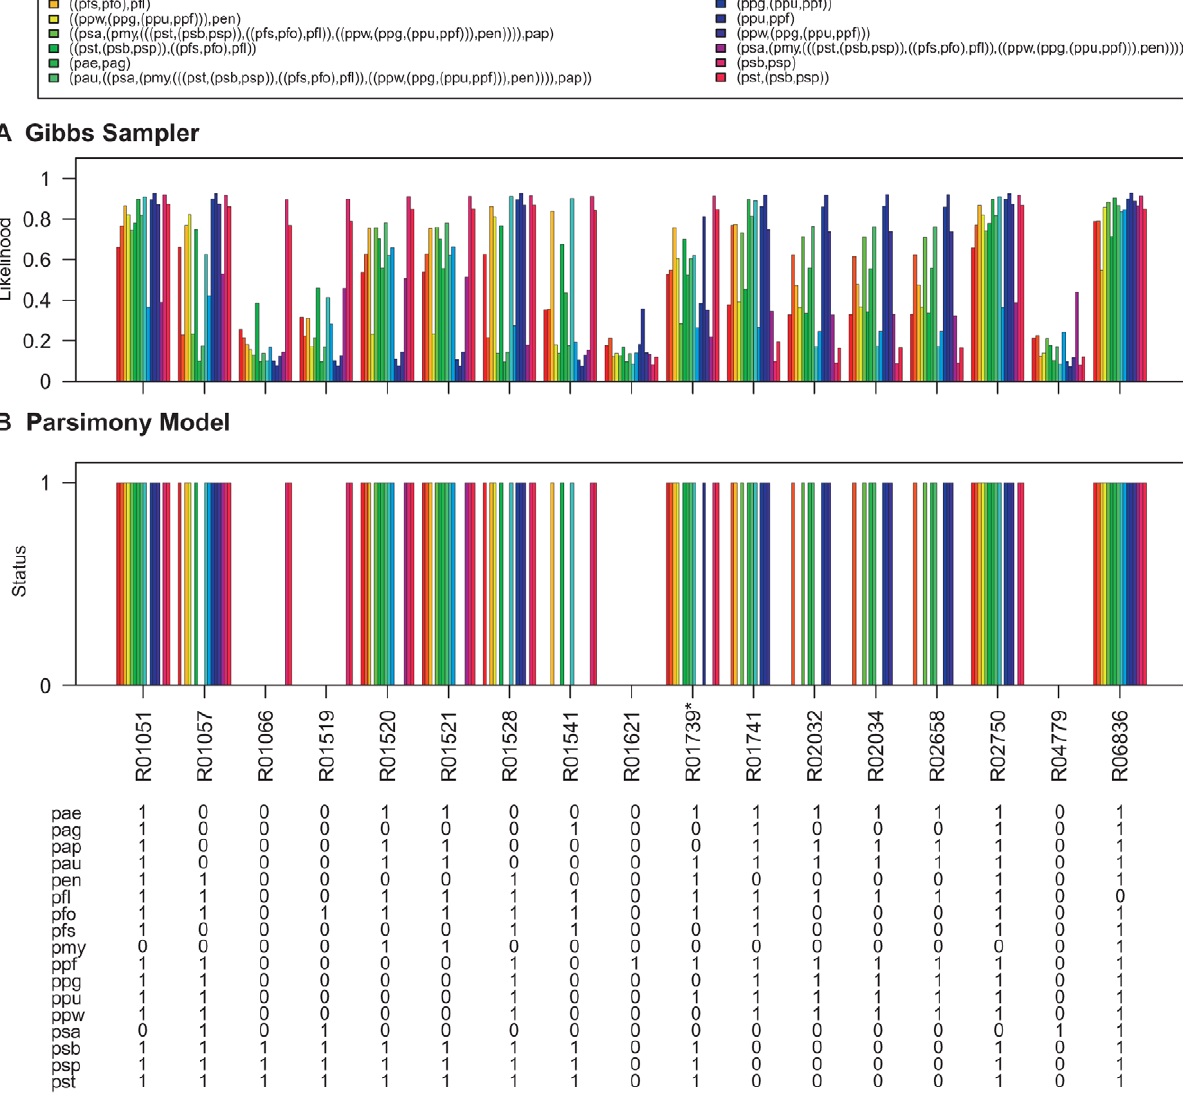
Figure 8. Ancestral network reconstruction for the pentose phosphate pathway map. The ancestral networks were reconstructed over the Pseudomonas phylogeny shown in Figure 6A. Also shown in the bottom panel is the distribution of reactions across different Pseudomonas strains. (A) Likelihood of being present for alterable reactions at various levels of Pseudomonas phylogeny obtained by calculating the proportion of times each hyperedge was present in the networks sampled by the Gibbs sampler. (B) Reaction status obtained under maximum parsimony calculated using the Fitch algorithm [26]. When assigning the reactions at the ancestral nodes the ties were resolved in favor of presence of reactions. Reactions for which parsimony failed to resolve ancestral predictions at the root are marked with an asterisk (*). Strain abbreviations: pae: P. aeruginosa PAO1, pap: P. aeruginosa PA7, pau: P. aeruginosa PA14, pag: P. aeruginosa LESB58, pen: P. entomophila L48, pfl: P. fluorescens Pf-5, pfo: P. fluorescens Pf0-1, pfs: P. fluorescens SBW25, pmy: P. mendocina ymp, ppf: P. putida F1, ppg: P. putida GB-1 ppu: P. putida KT2440, ppw: P. putida W619, psa: P. stutzeri A1501, psb: P. syringae pv. syringae B728a, psp: P. syringae pv. phaseolicola 1448A, and pst: P. syringae pv. tomato DC3000.